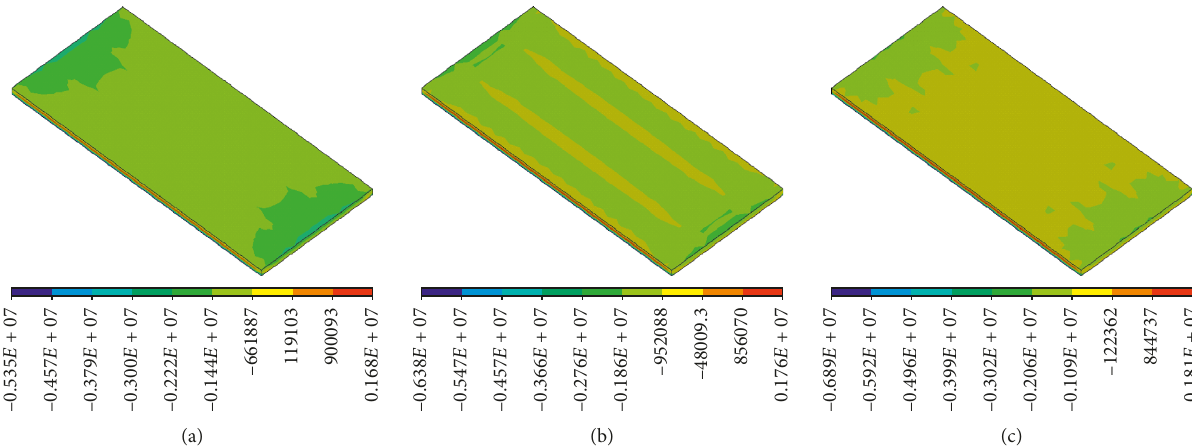
Figure 15: Transverse stress of the self-compacting concrete layer under condition 1. (a) P